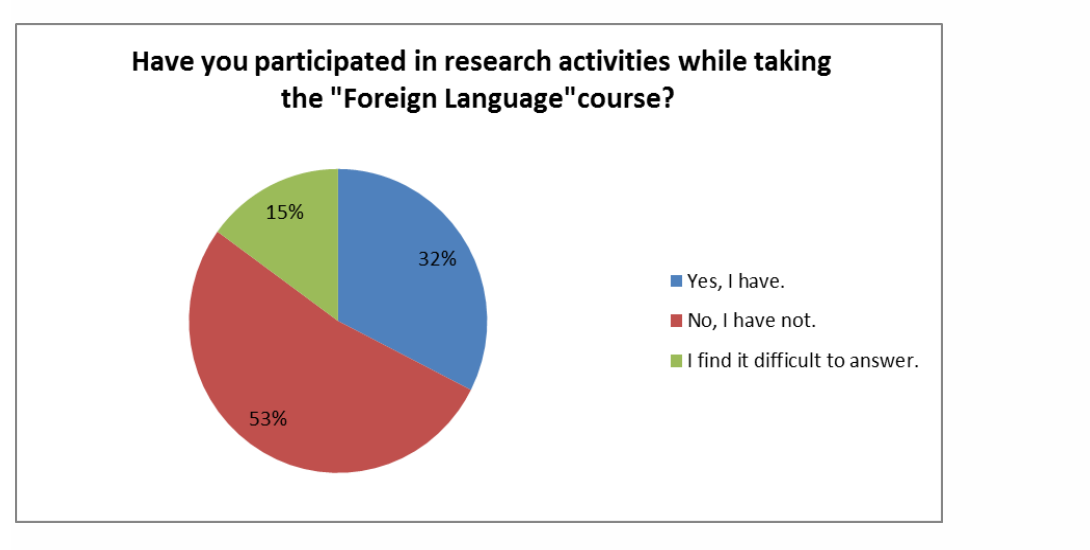
Figure 2. Mastery of a foreign language necessary to conduct research activities It is necessary to increase the presented indicators since some graduates plan to apply for a Master's program, including study abroad options. Knowledge of a foreign language and research culture is an absolute advantage that makes a specialist competitive.